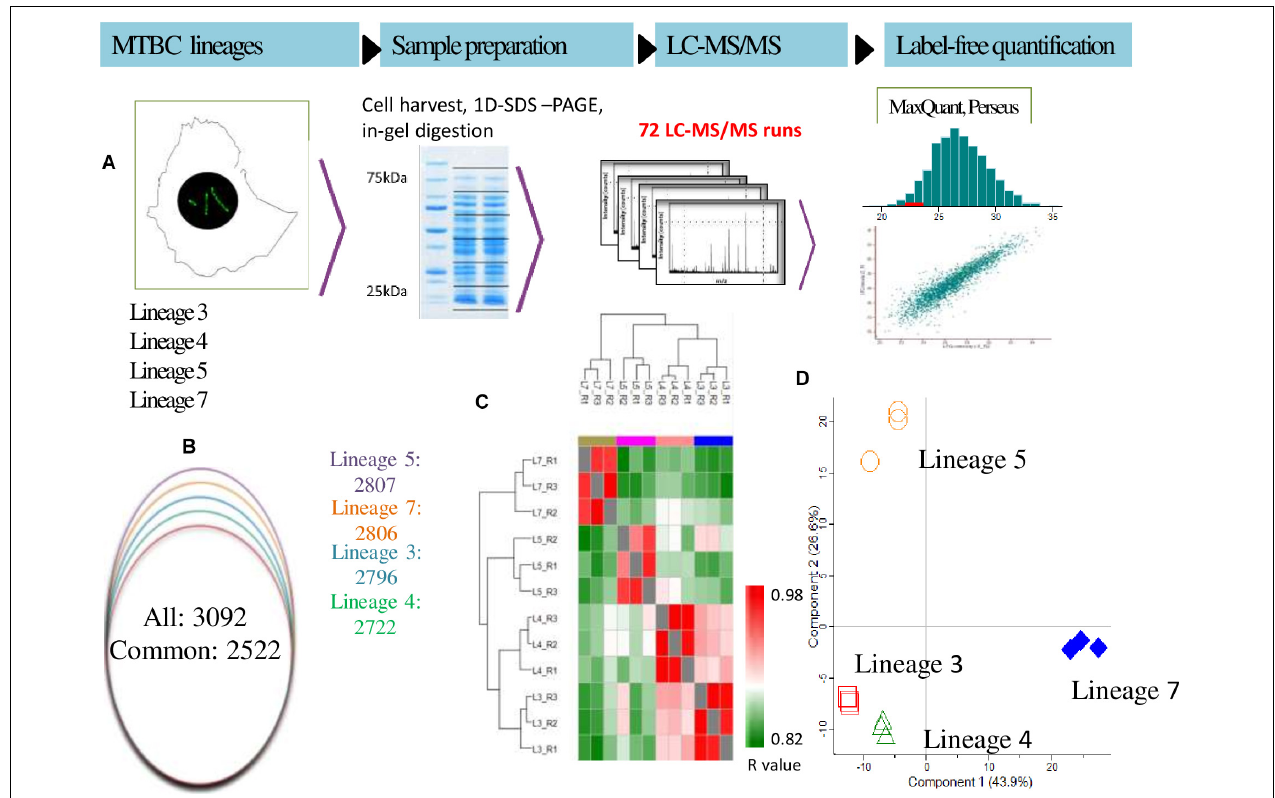
FIGURE 1 | (A–D) Proteomics analysis of M. tuberculosis complex (MTBC) lineages. (A) Experimental workflow used in this study includes lysis, protein precipitation, tryptic digestion, peptide desalting, and ultra-high-performance liquid chromatography followed by mass spectrometry on a Q exactive plus mass spectrometer (Thermo-Fischer, Inc.). Label free quantification and the downstream statistical analysis were performed using MaxQuant and Perseus software, respectively. (B) Overlap of differentially abundant proteins in MTBC Lineages 3, 4, 5, and 7. (C) iBAQ-based ranking of protein abundances in various lineages. (D) Principal component analysis for protein abundance data from MTBC lineages. Samples were separated by lineage (component 1, 43.9% variance) and by biological groups (component 2, 26.6% variance). Only proteins identified in all samples were considered for the analysis. Data from three biological replicates are